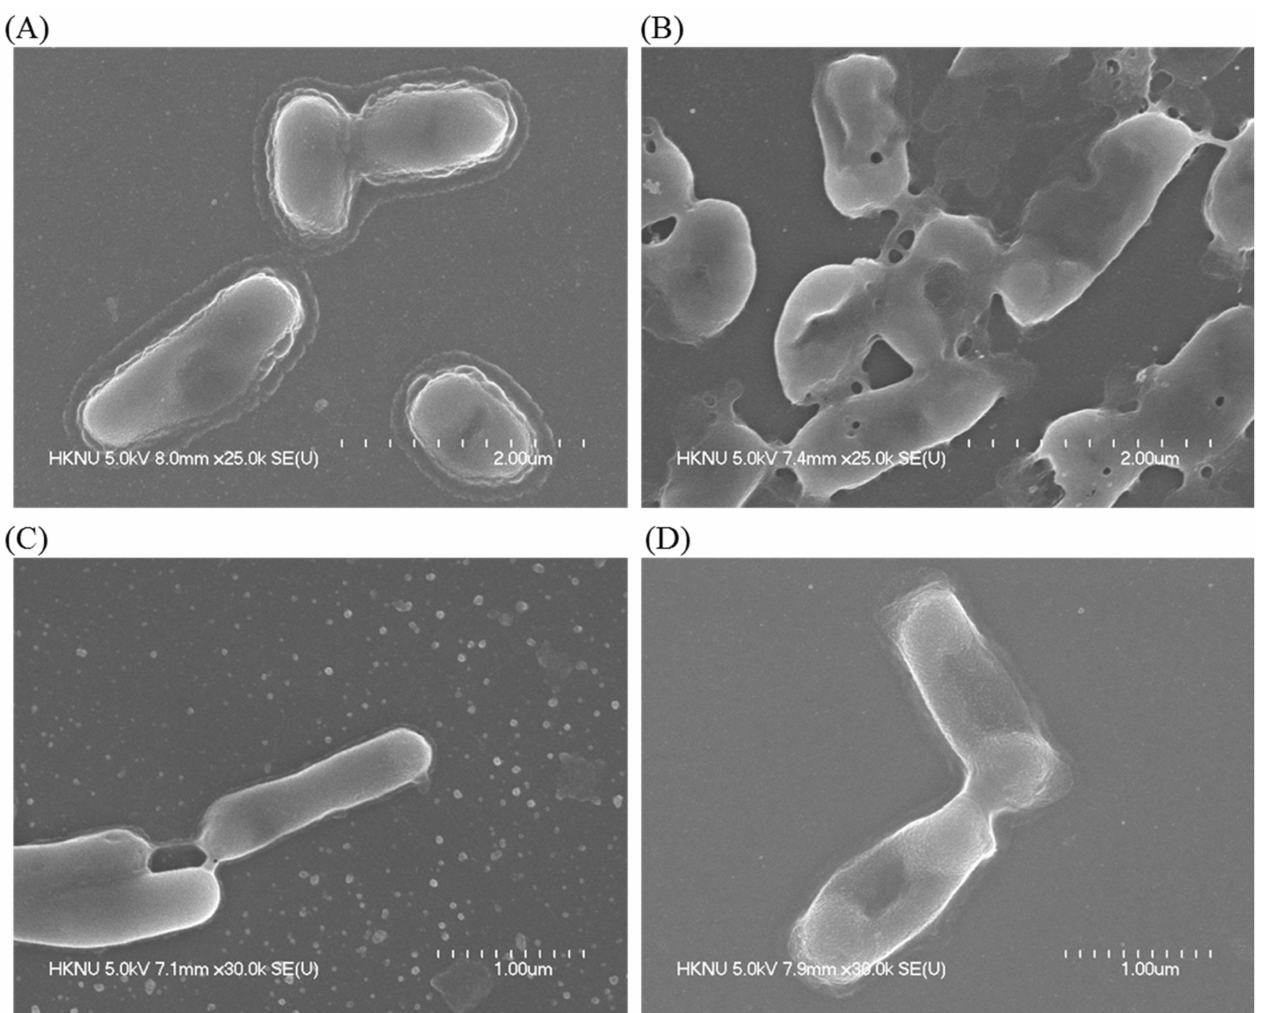
Figure 9. SEM images of normal K. pneumoniae cells ( A ), 1 × MBC AgNPs treated K. pneumoniae cells ( B ), normal S. Enteritidis cells ( C ), 1 × MBC AgNPs treated S. Enteritidis cells ( D